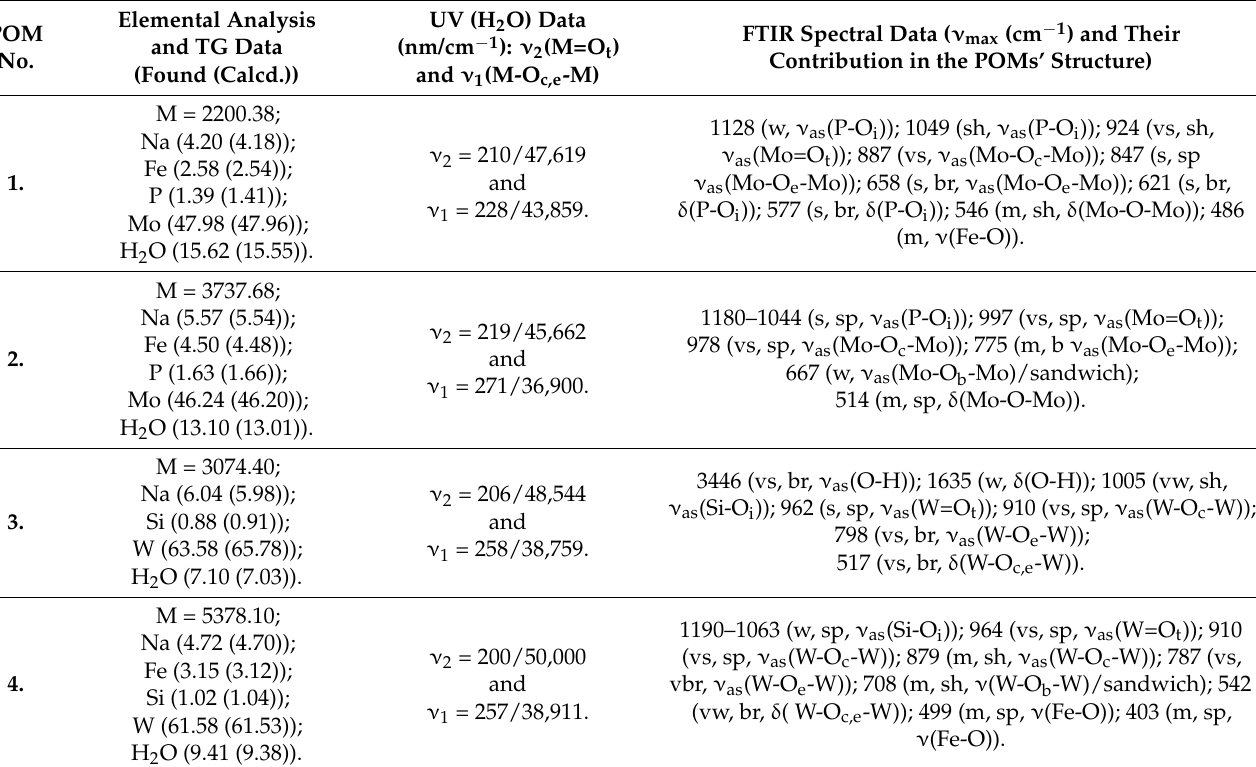
Table 2. Physico-chemical data of